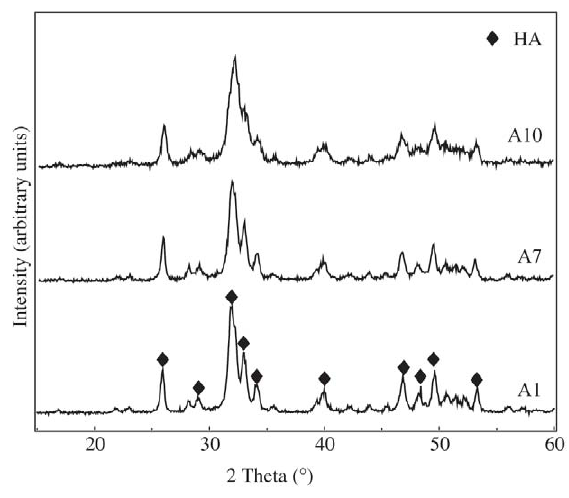
Figure 4. XRD patterns of the synthetic precipitate powders after thermal treatment on R1 (sample A1), R2 (sample A7) and R3 (sample A10).